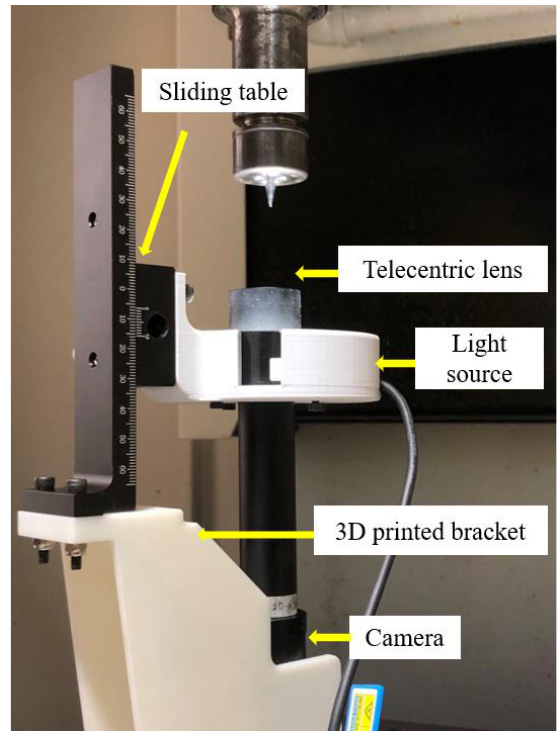
Figure 2. Image acquisition system.